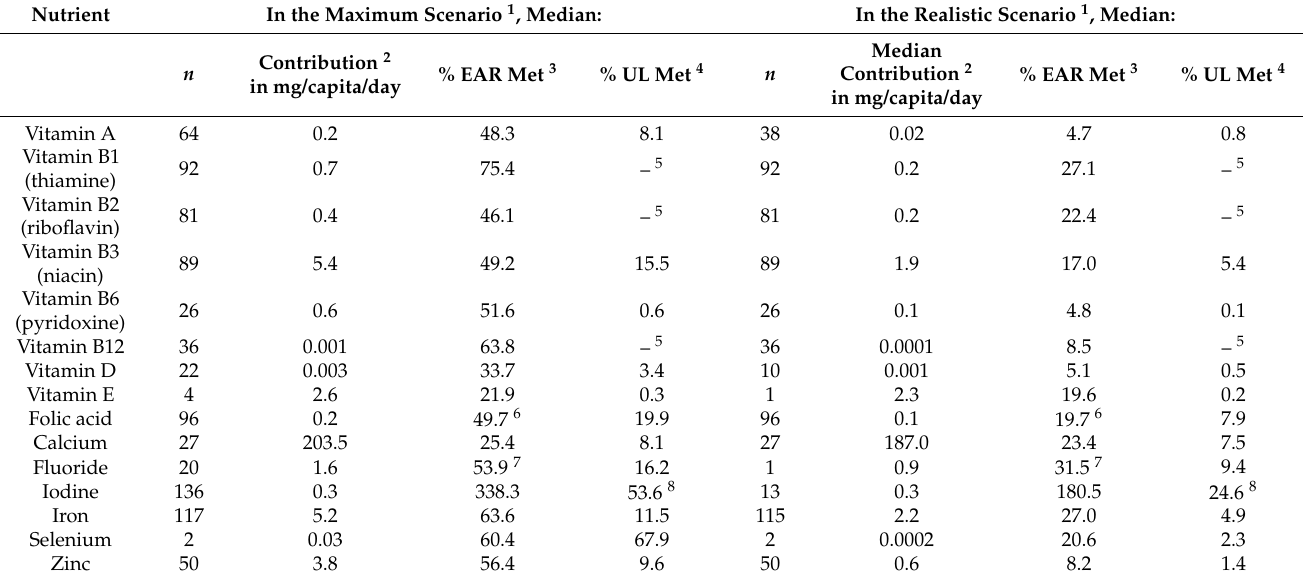
Table 2. Potential nutrient contribution under maximum and realistic scenarios expressed as median contribution (mg/capita/day), percent of Estimated of Average Requirement (EAR) met, and percent of Tolerable Upper Intake Level (UL) met for nutrients in fortification requirements for maize flour, oil, rice, salt, and wheat flour (combined).